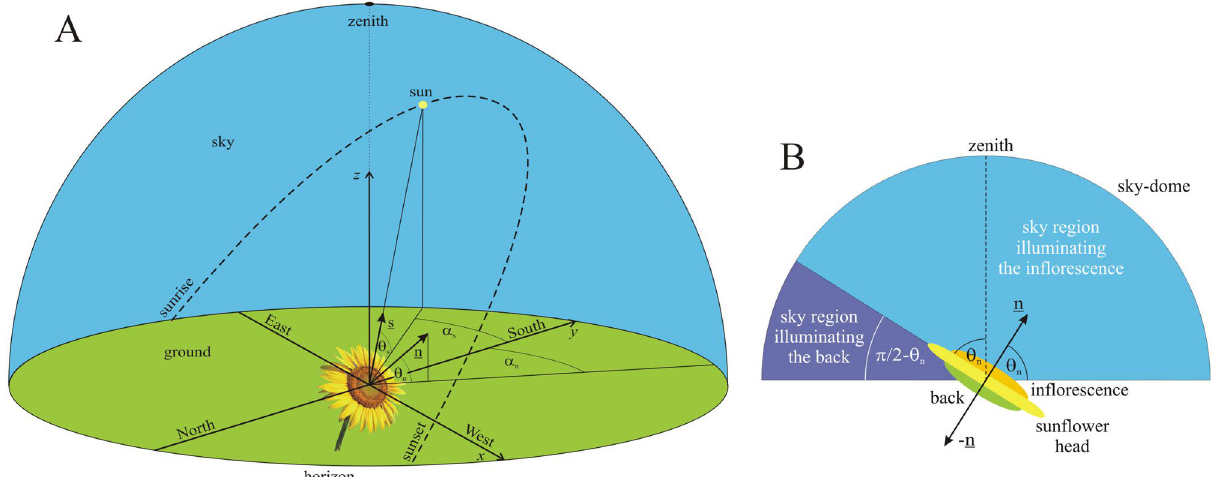
Figure 7. Geometry of a mature sunflower head and the sky. ( A ) Geometry of the sky-dome with the unit vectors n and s characterizing the normal vector of a mature sunflower head and the direction of the Sun, respectively. ( B ) For calculation of the proportion (θ n + π/2)/π of the celestial hemisphere from which a sunflower inflorescence with elevation angle θ n of its normal vector n receives diffuse skylight (light blue) and the proportion (π/2-θ n )/π of the sky-dome from which the back (with normal vector − n) of the head receives diffuse skylight (dark